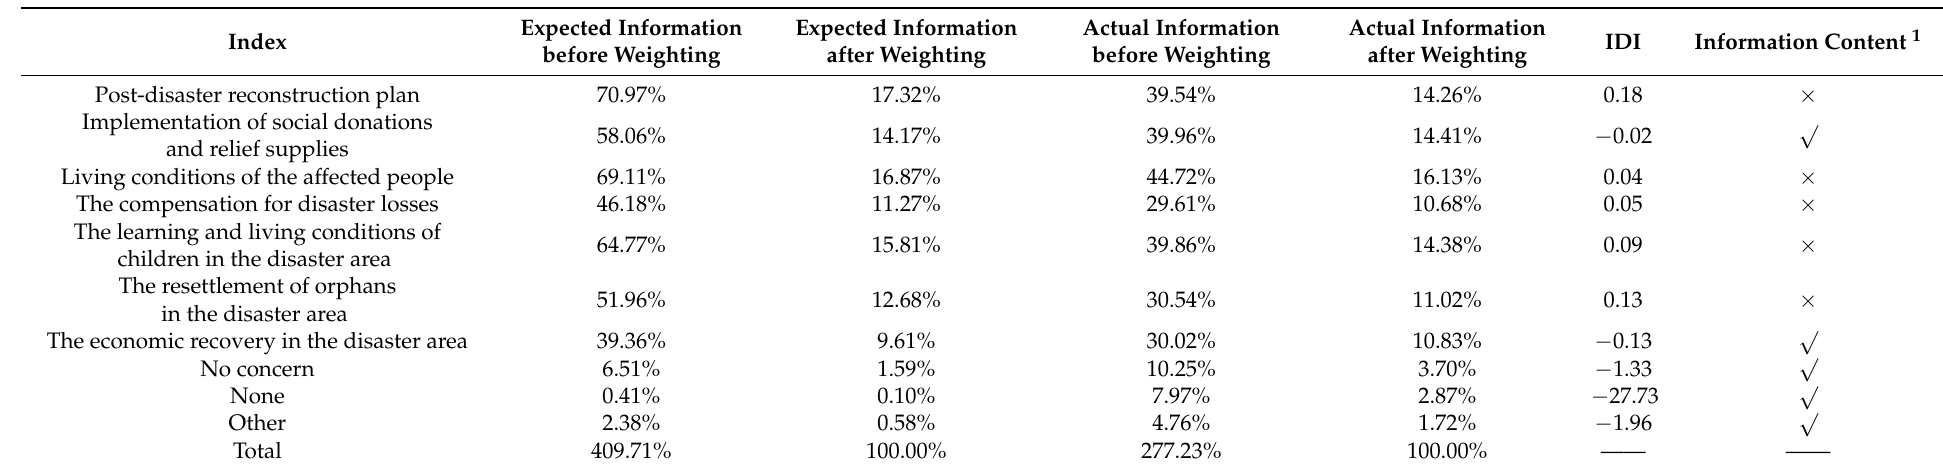
Table 7. Information deviation index in the resolution stage of an earthquake